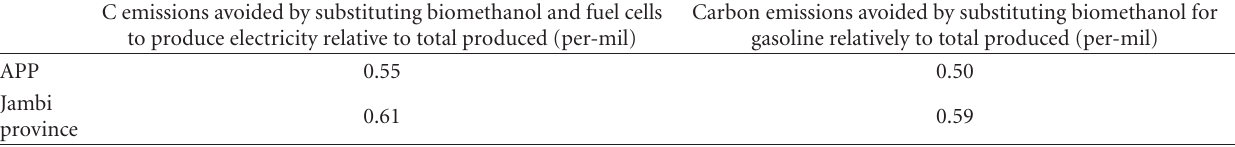
Table 3: Proportion of C emissions avoided by substituting electricity generated from fuel cells using biomethanol in place of electricity generated from fossil fuels and by substituting biomethanol for gasoline consumed in transportation fuels. Assumptions: timber is converted into biomethanol at a 50% conversion e ffi